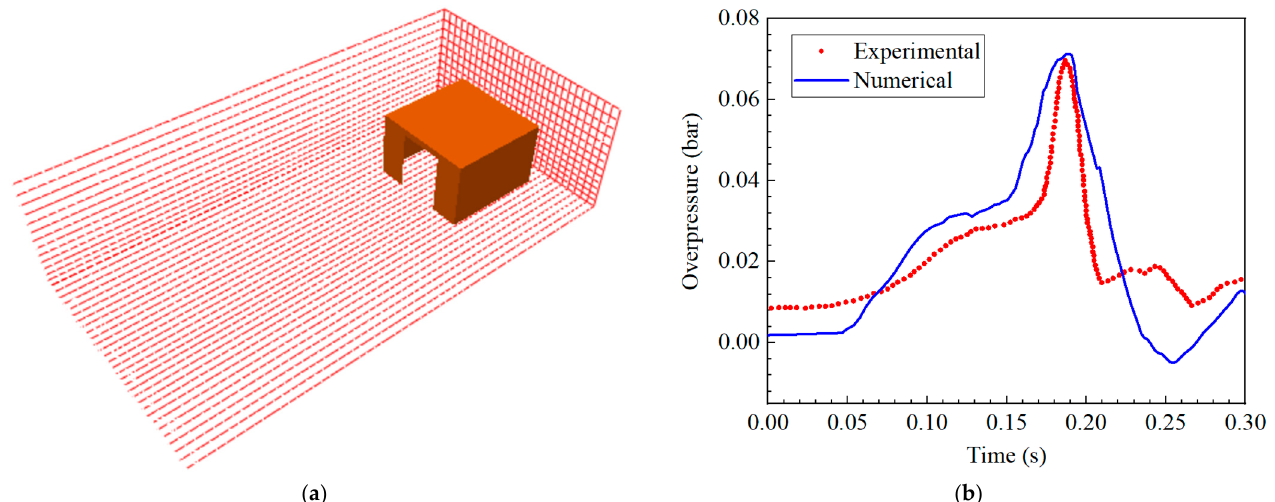
Figure 1. (a) Grid for validation, (b) comparison of calculated and measured overpressures of the Figure 1. ( a ) Grid for validation, ( b ) comparison of calculated and measured overpressures of the explosion in a chamber. explosion in a